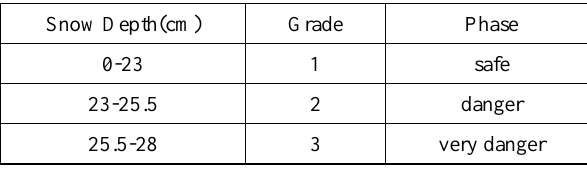
Table 4. The Snow Hazard Risk